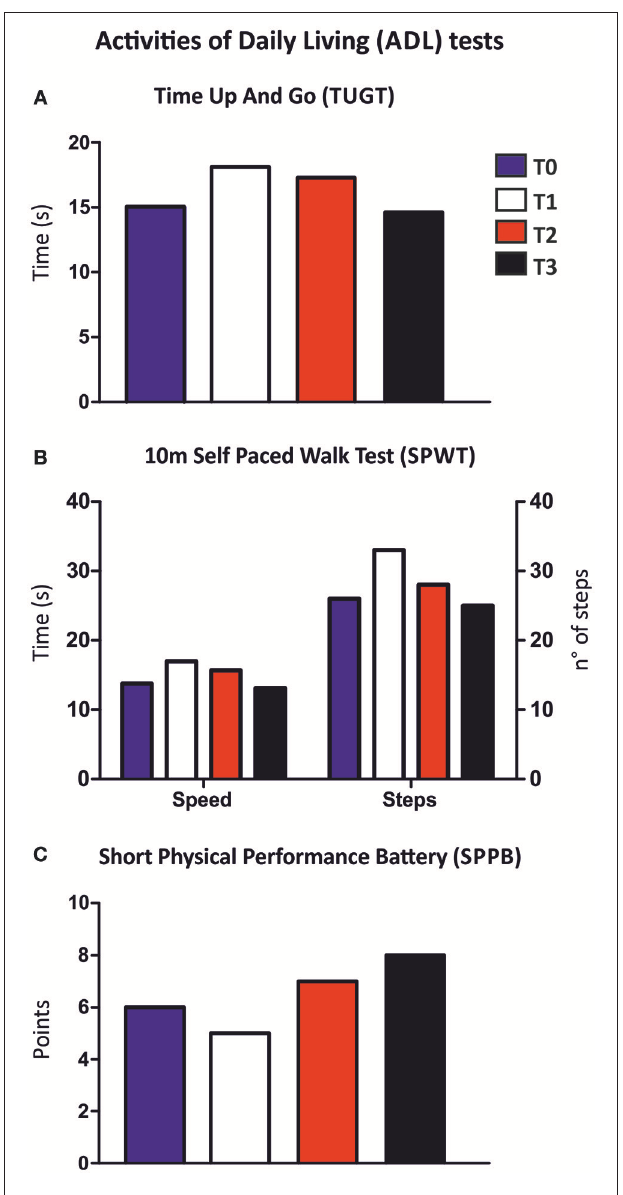
FIGURE 5 | Activities of daily living (ADL) tests. Results of ADL tests of before (T0) and after 5 (T1), 14 (T2), and 26 (T3) months of home-based FES training: (A) 10m self-paced walk test; (B) TUGT, time up and go test; and (C) SPPB, short physical performance